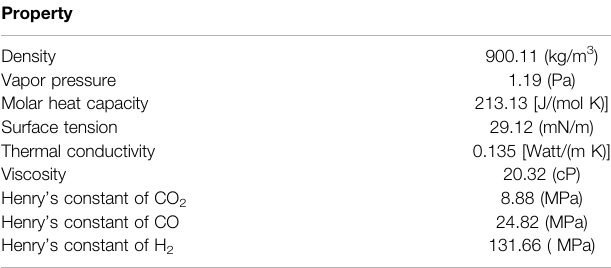
TABLE 2 | Thermodynamic properties of deca-men (1:1) at 25 ° C. Property